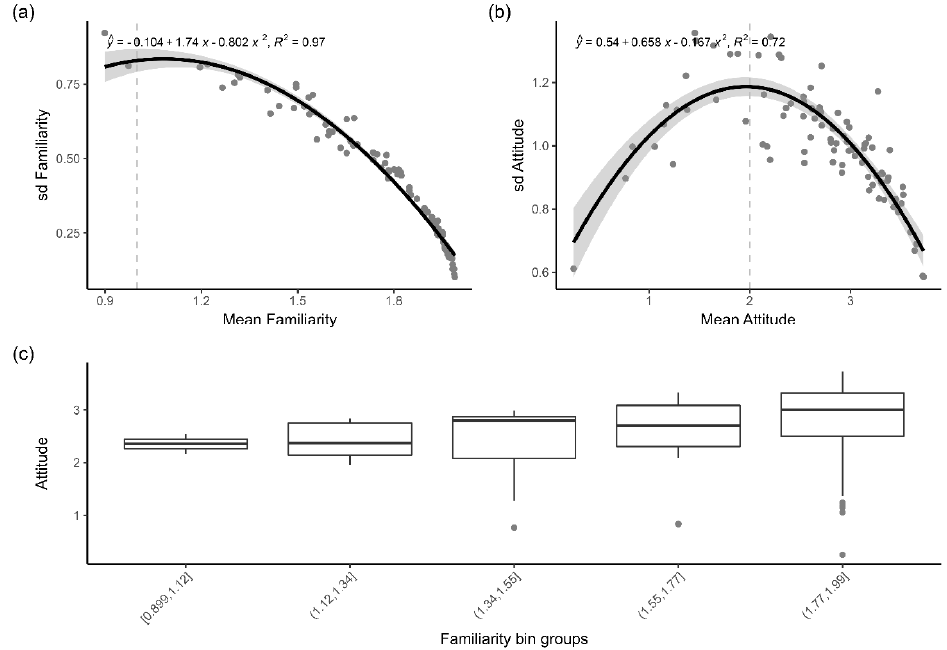
Figure A2. Relationship between variability in familiarity or attitude and the mean of the other variable. Each point in ( a – c ) represents a species and means, and standard deviations are calculated across participants. ( a ) Variability in familiarity (standard deviation) against mean attitude. ( b ) Variability in opinion (standard deviation) against mean familiarity. The dashed vertical line shows the middle value in the questionnaire. The grey areas around the lines represent the standard error. ( c ) Attitude as a function of familiarity. Familiarity was divided into five groups of equal distance, and then boxplots were made to visualize the attitudes across species in those groups.